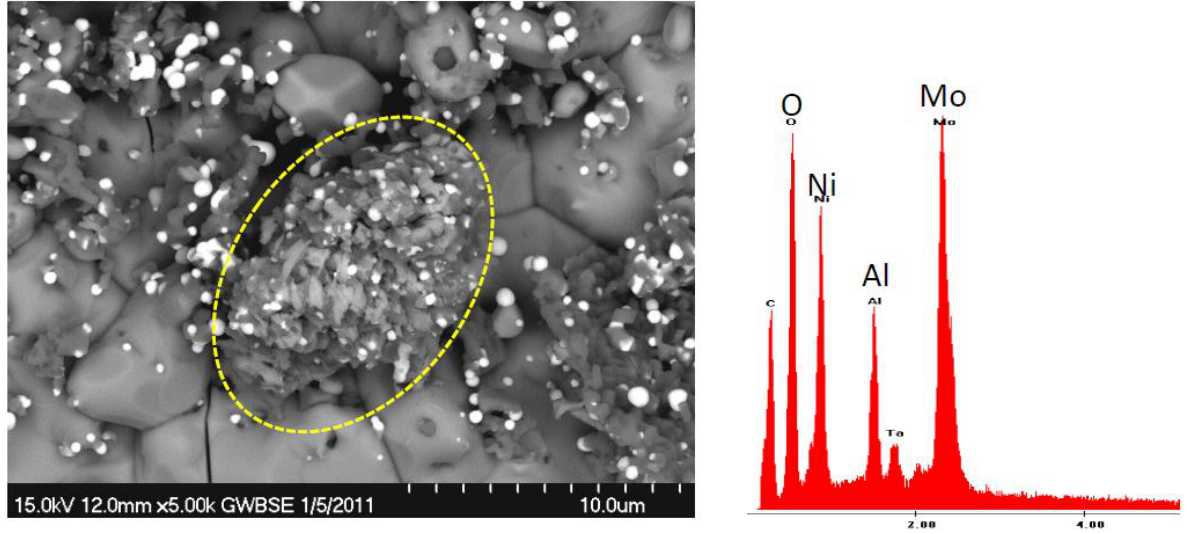
Figure 13. BSE/SEM and EDS spectra of a high Mo, flakey nodule (circled) on a NiO base scale. From detached flake of the TGA sample (# 143) in Figure